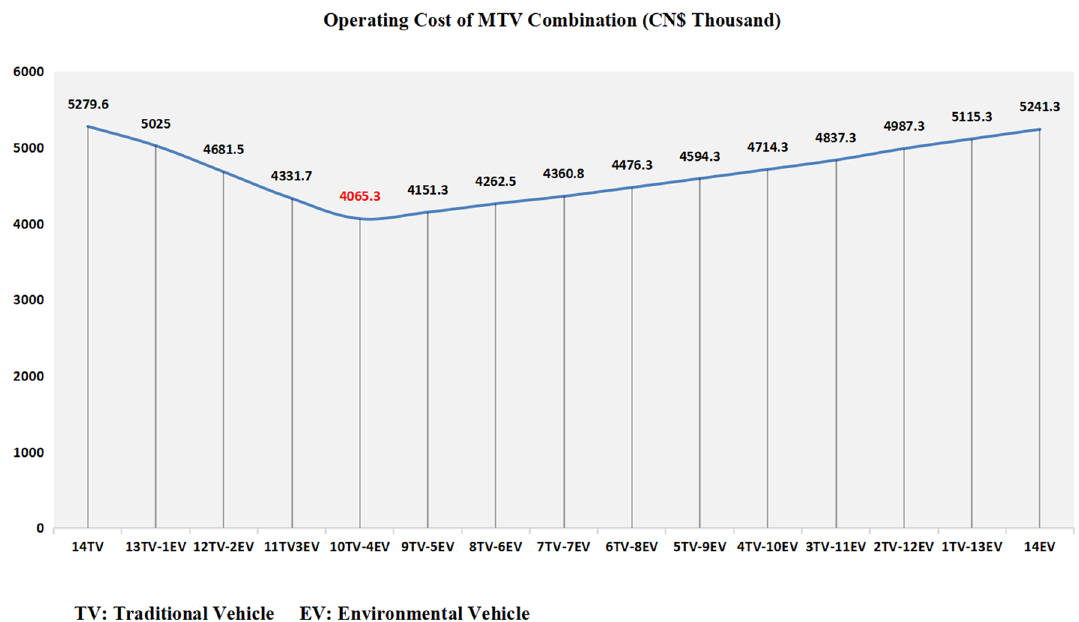
Figure 5. Operating costs of different numbers of MTV